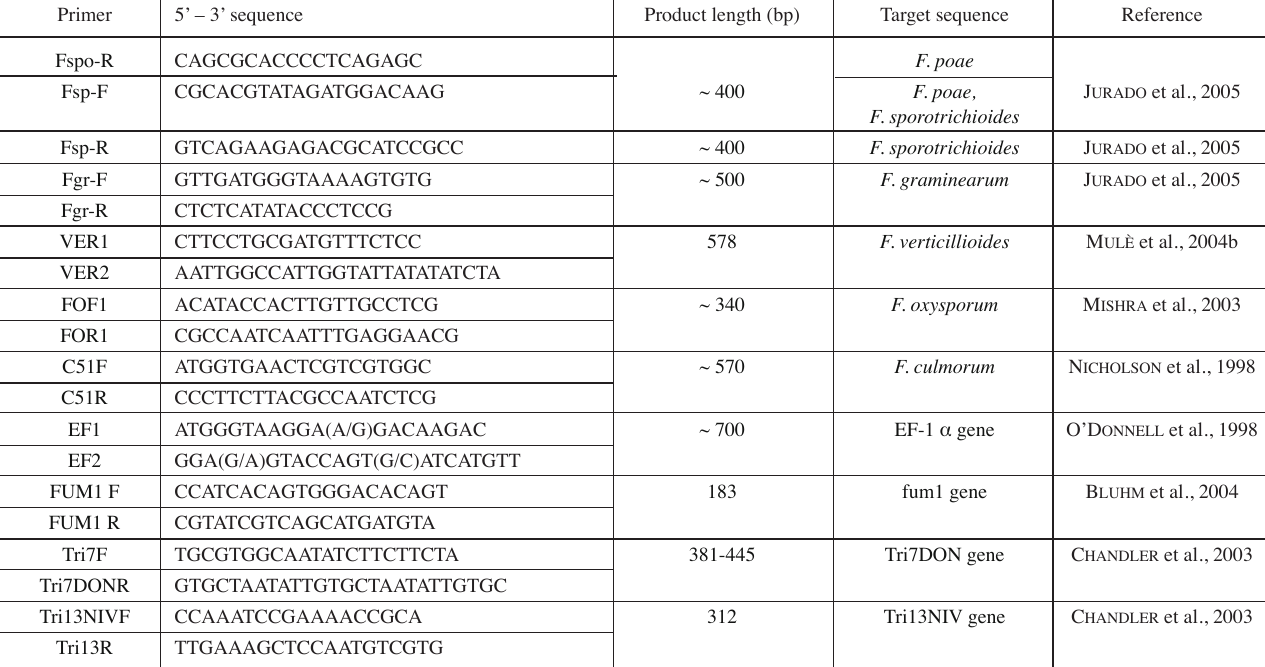
Tab. 1: List of primer sequences, expected DNA fragment length and sources of primers.